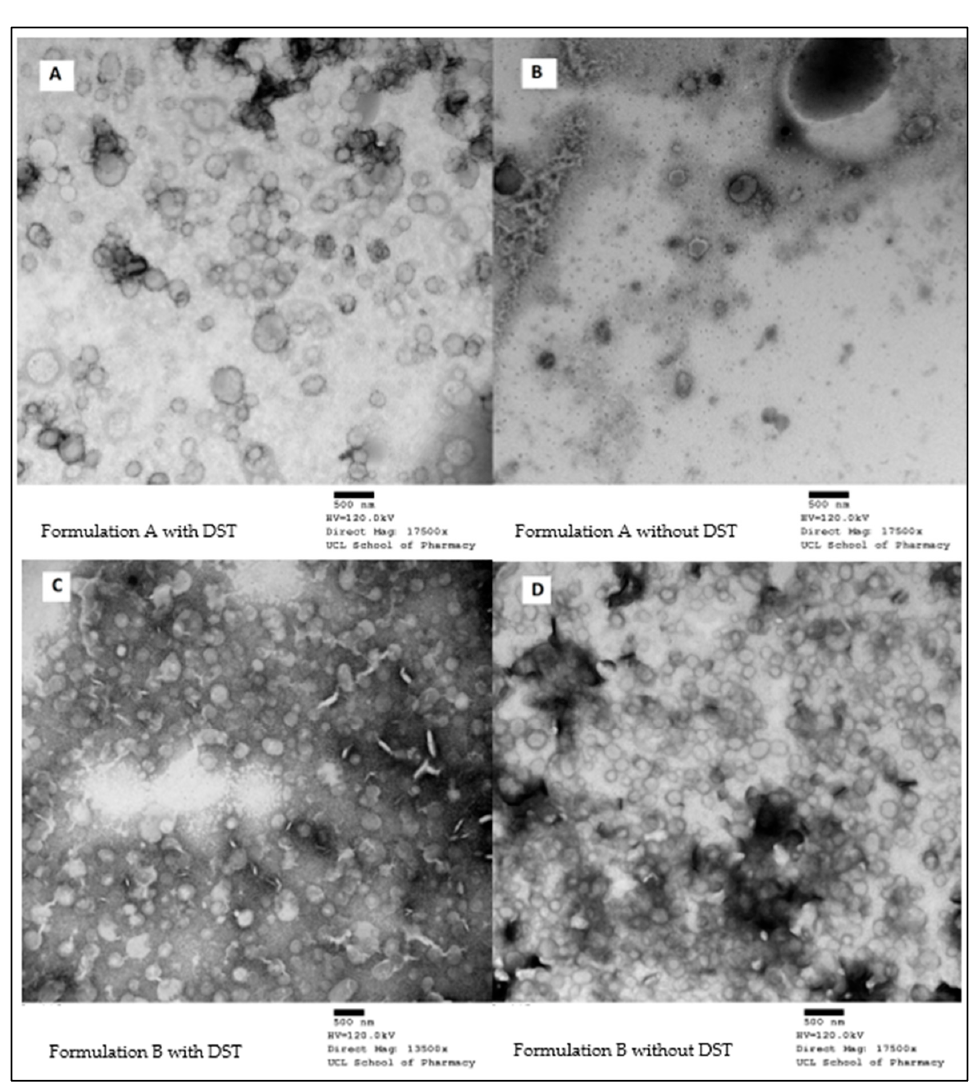
Figure 2. TEM micrographs of Formulation A with dutasteride ( A ), and without dutasteride ( B ) and Formulation B with dutasteride ( C ), and without dutasteride ( D ).